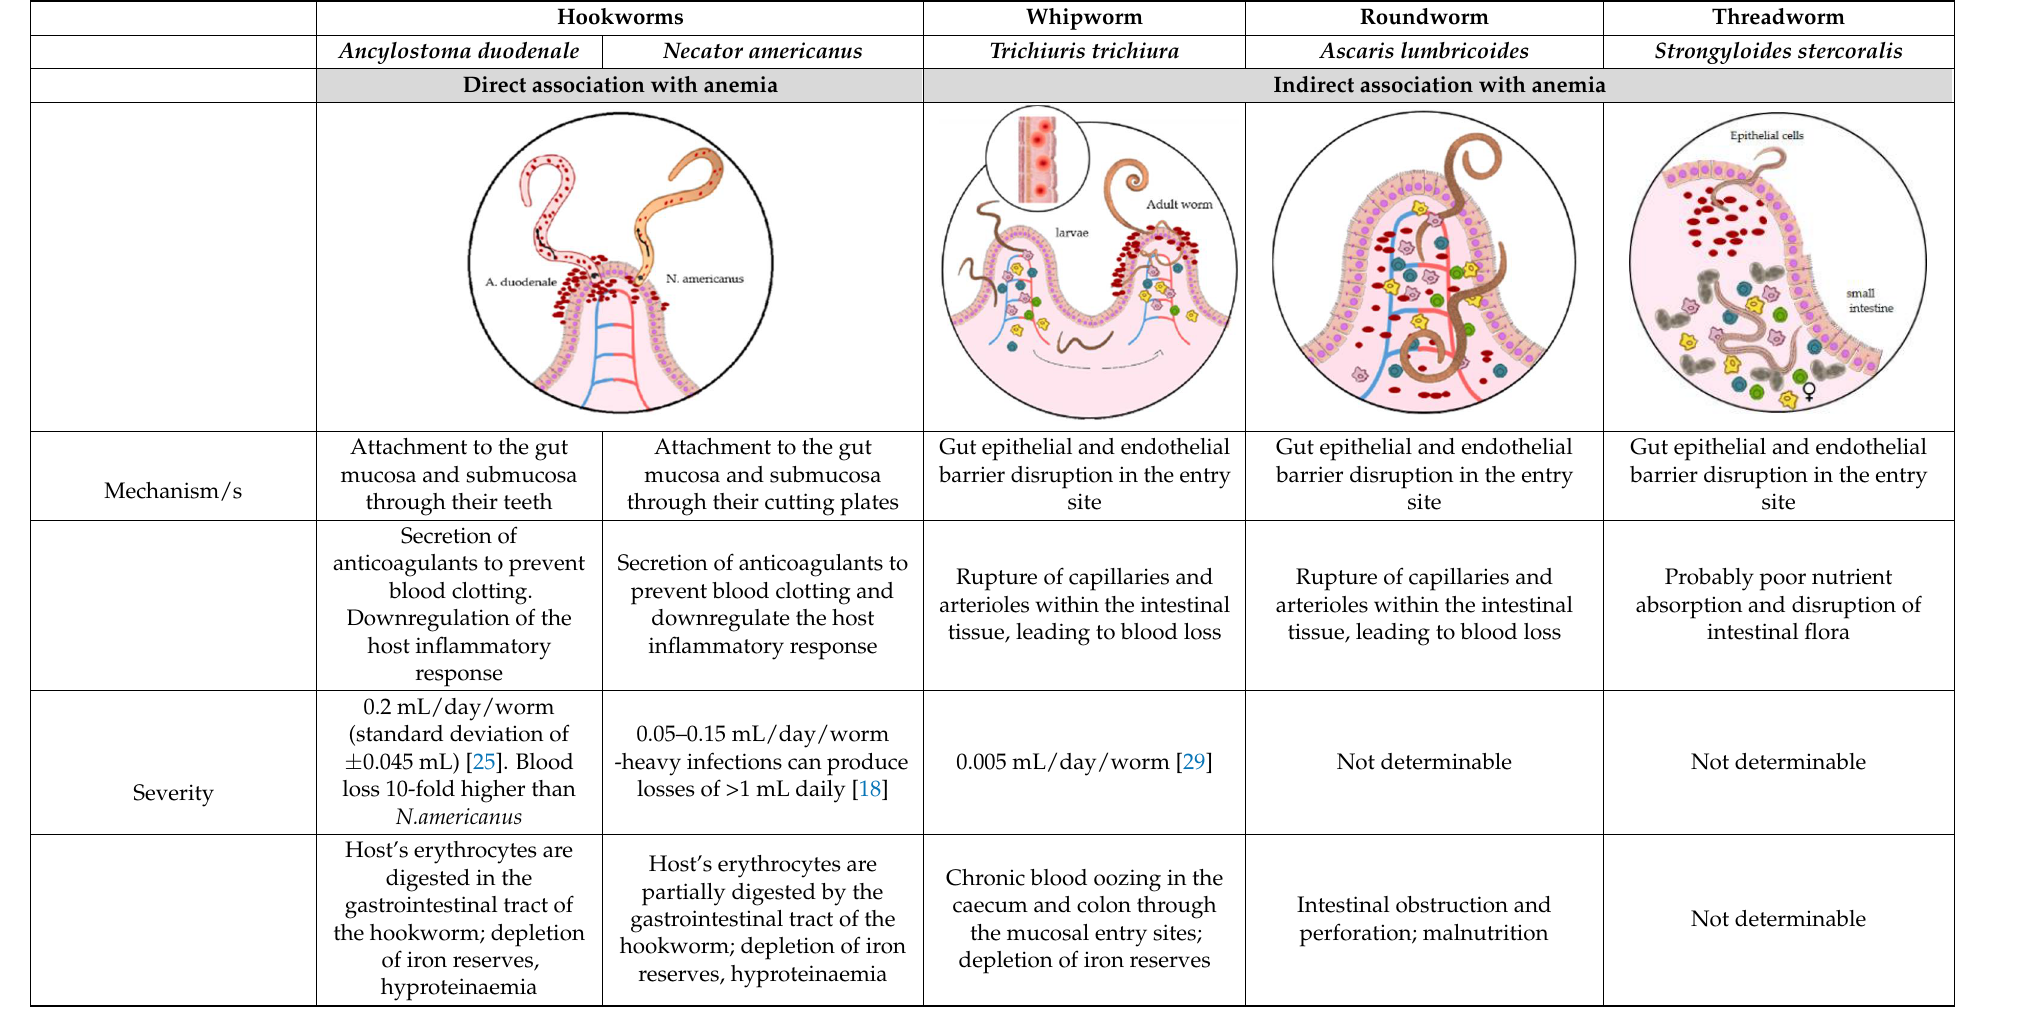
Table 1. Mechanisms by which soil-transmitted helminths cause, or may contribute to, anaemia, and the association between the disease severity and worm burden.